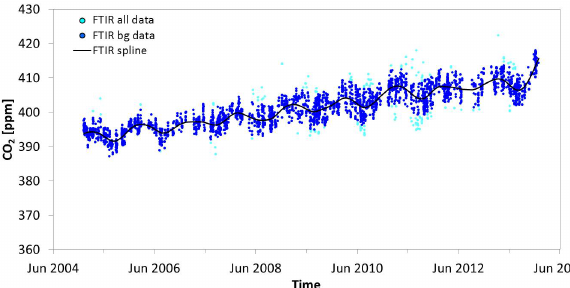
Figure 2. CO 2 mole fractions of the FTIR measurements as a func- tion of time in ppm in the column above JFJ: all hourly averages be- fore filtering (light blue), hourly averages after filtering (dark blue), and the spline (black line). The light blue points correspond to about 5% of the whole data